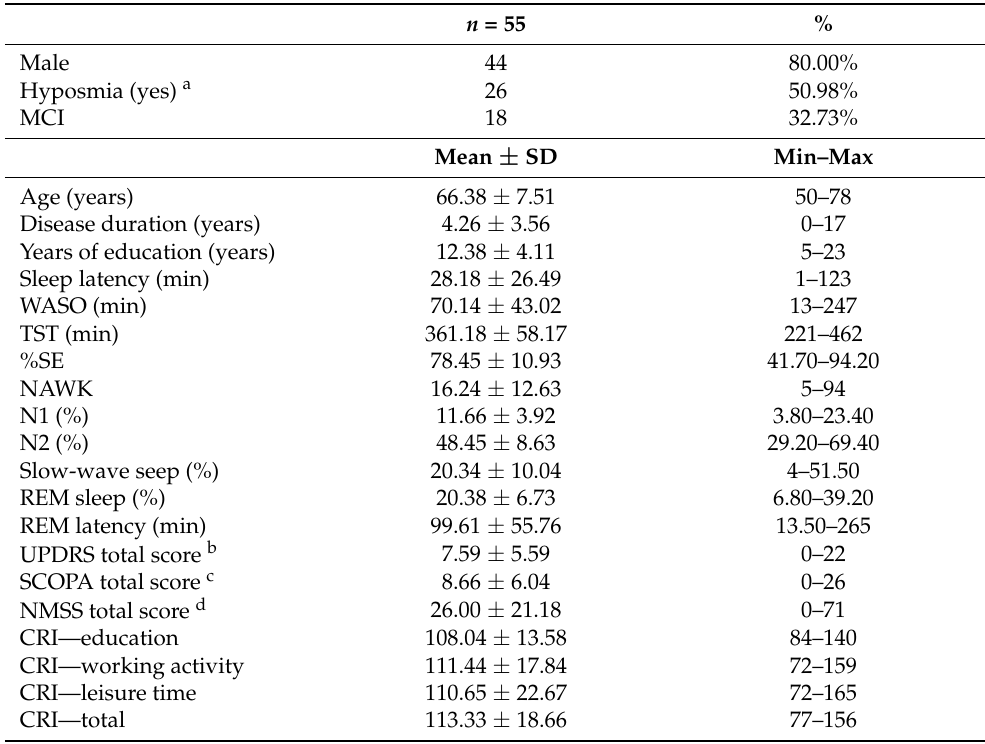
Table 1. Population characteristics.